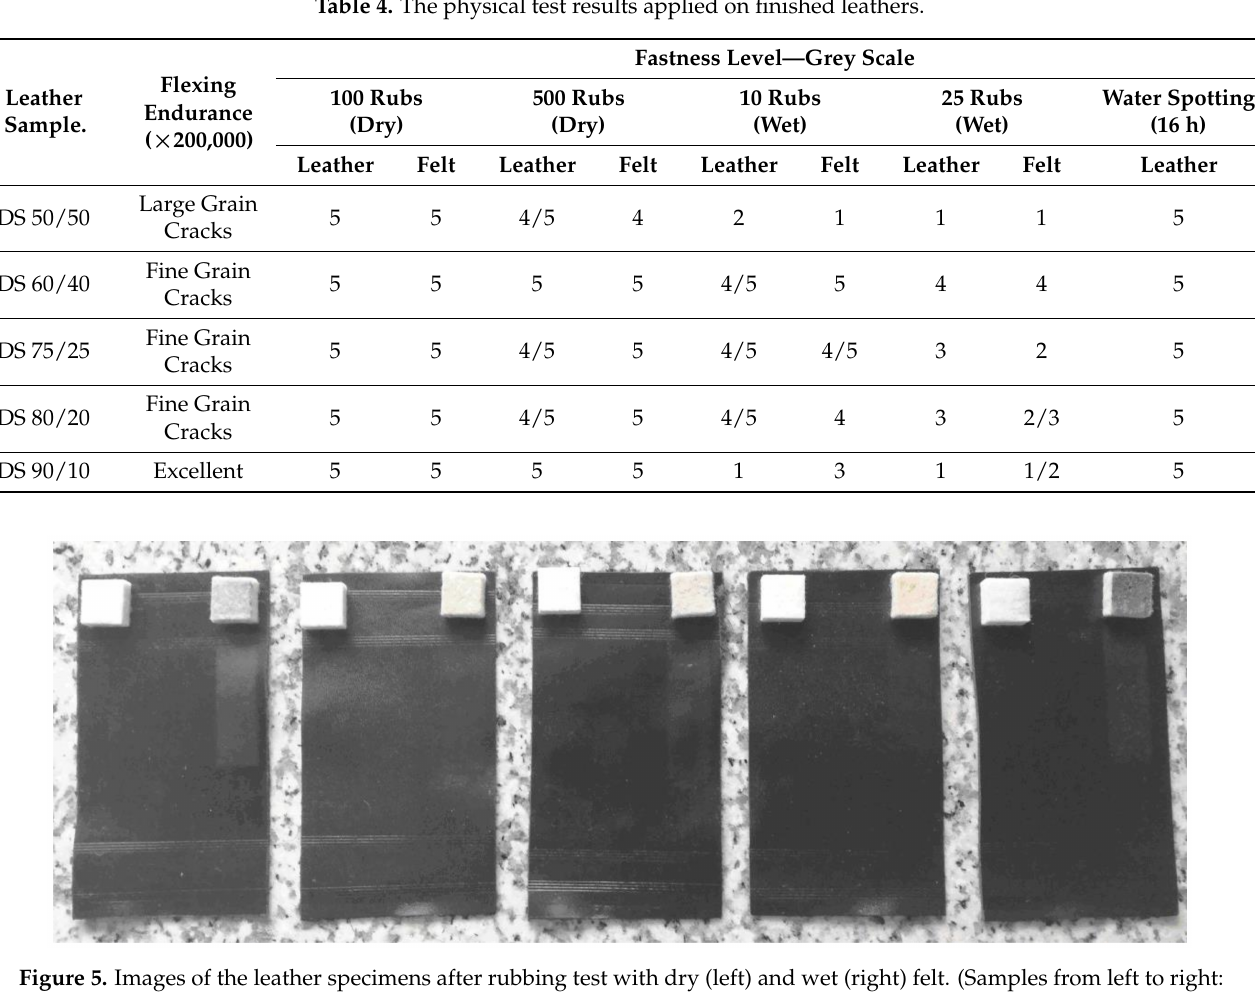
Table 4. The physical test results applied on finished leathers.